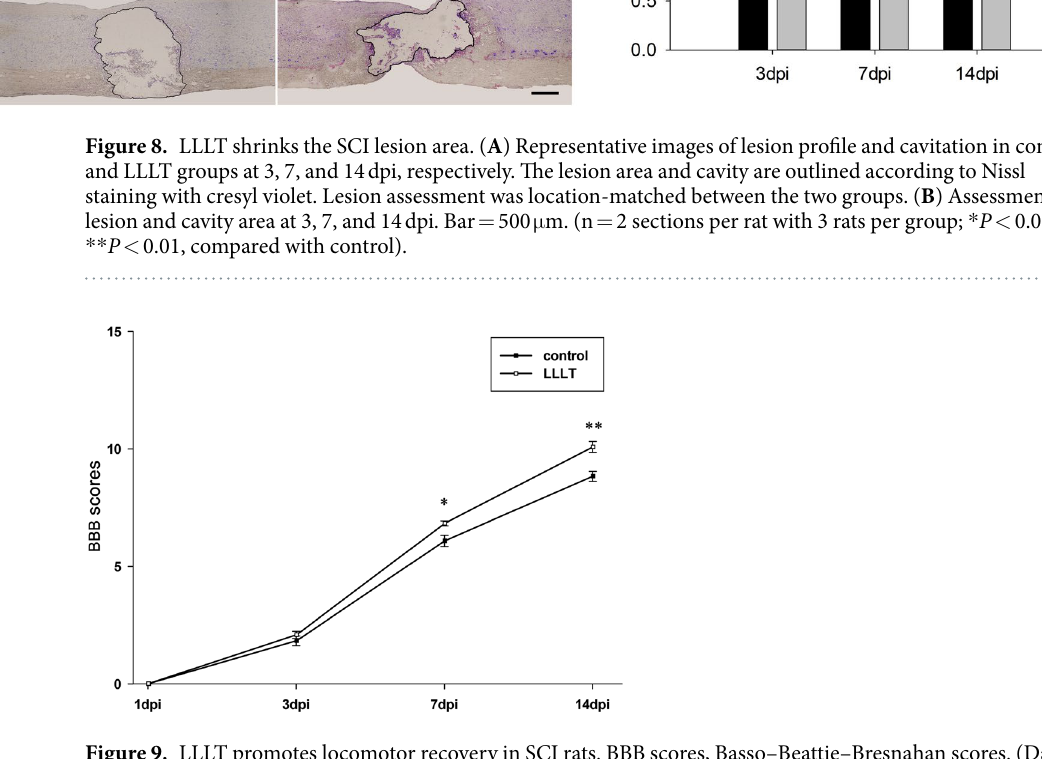
Figure 9. LLLT promotes locomotor recovery in SCI rats. BBB scores, Basso–Beattie–Bresnahan scores. (Data are presented as mean ± SEM for n = 6 rats per group; * P < 0.05; ** P < 0.01, compared with